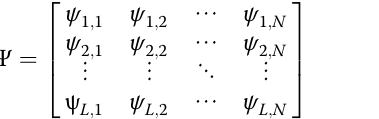
; ψ ! ; Δ ! ; j ¼ 1 ; 2 ; ⋯ ; N g j Þ j j